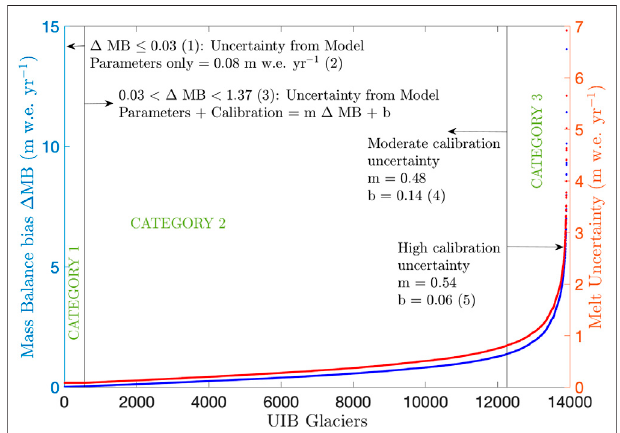
FIGURE3| Meltuncertainty (solidredline)ofUpperIndusBasinglaciers depicted as a function of the model-measured mass balance bias ( “ Δ MB, ” solid blue line), based on sensitivity analysis of a 12-glacier set that represented Upper Indus Basin subbasins and glacier sizes. The vertical lines show where the MB difference is 0.03 and 1.37 m w.e. yr − 1 . At these values the uncertainty category changes from 1 to 2 and from 2 to 3, respectively. A detailed derivation of all values in the fi gure is given in the Supplementary Material